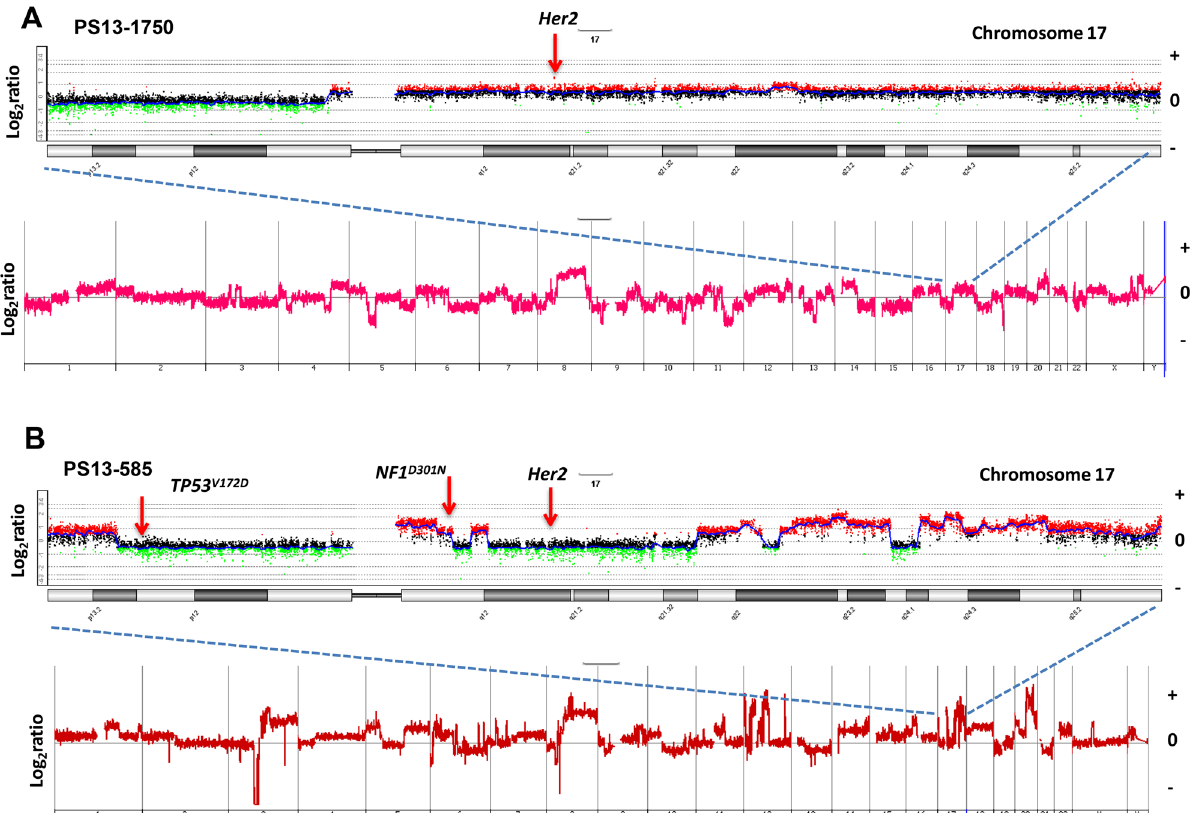
Figure 5. Genomic analysis of ERBB2 in PS13-1750 and PS13-585. Whole genome and chromosome 17 CNV plots of ( A ) PS13-1750 and ( B ) PS13-585. Both tumors were scored as ERBB2 3+ by IHC of single